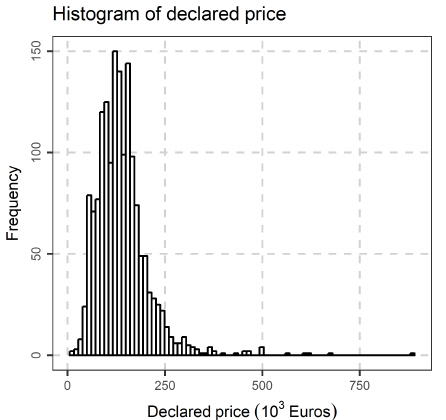
Figure 8. Accepted Price vs. Municipality.